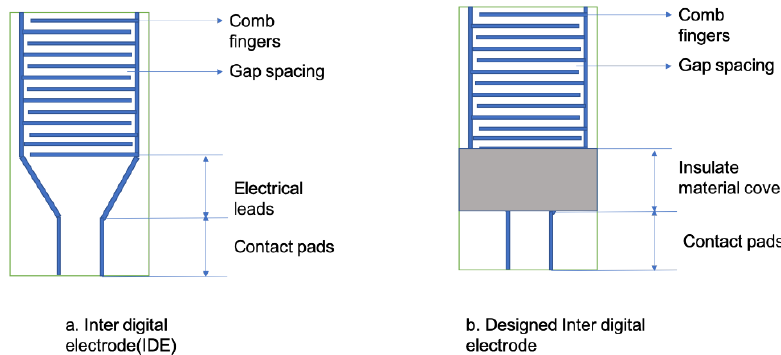
Figure 1. ( a ) original commercial sensor with gold covering; ( b ) designed in laboratory, cover the original IDE’s electrical leads with insulate material to passivate them.